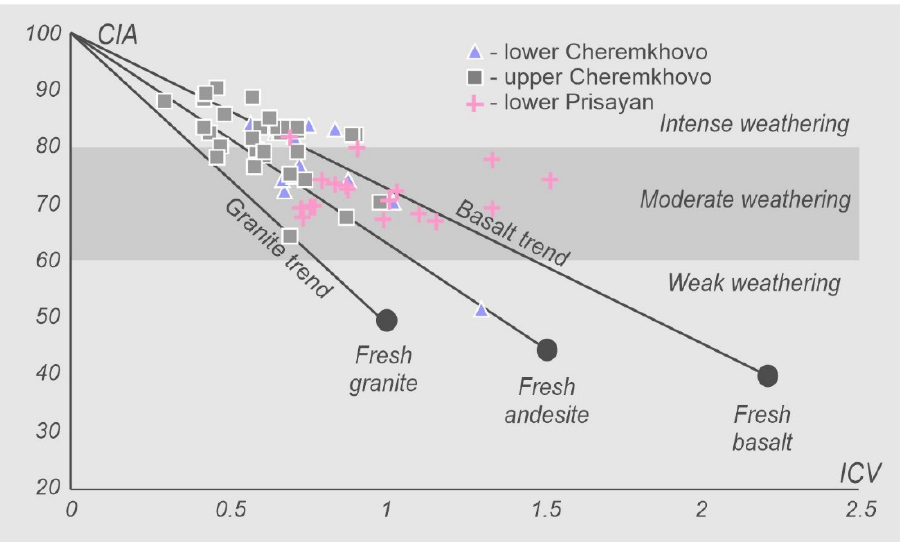
Figure 13. The plot of the index of compositional variability (ICV) versus CIA. The trends of granite, andesite, and basalt are from [49] .